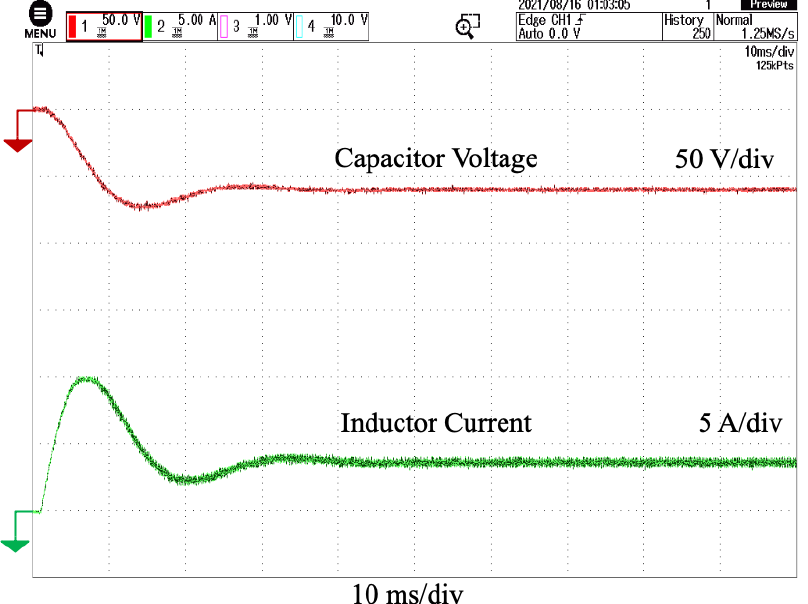
Figure 12. Analytical expression of capacitor voltage and inductor current over continous time from S 4 .